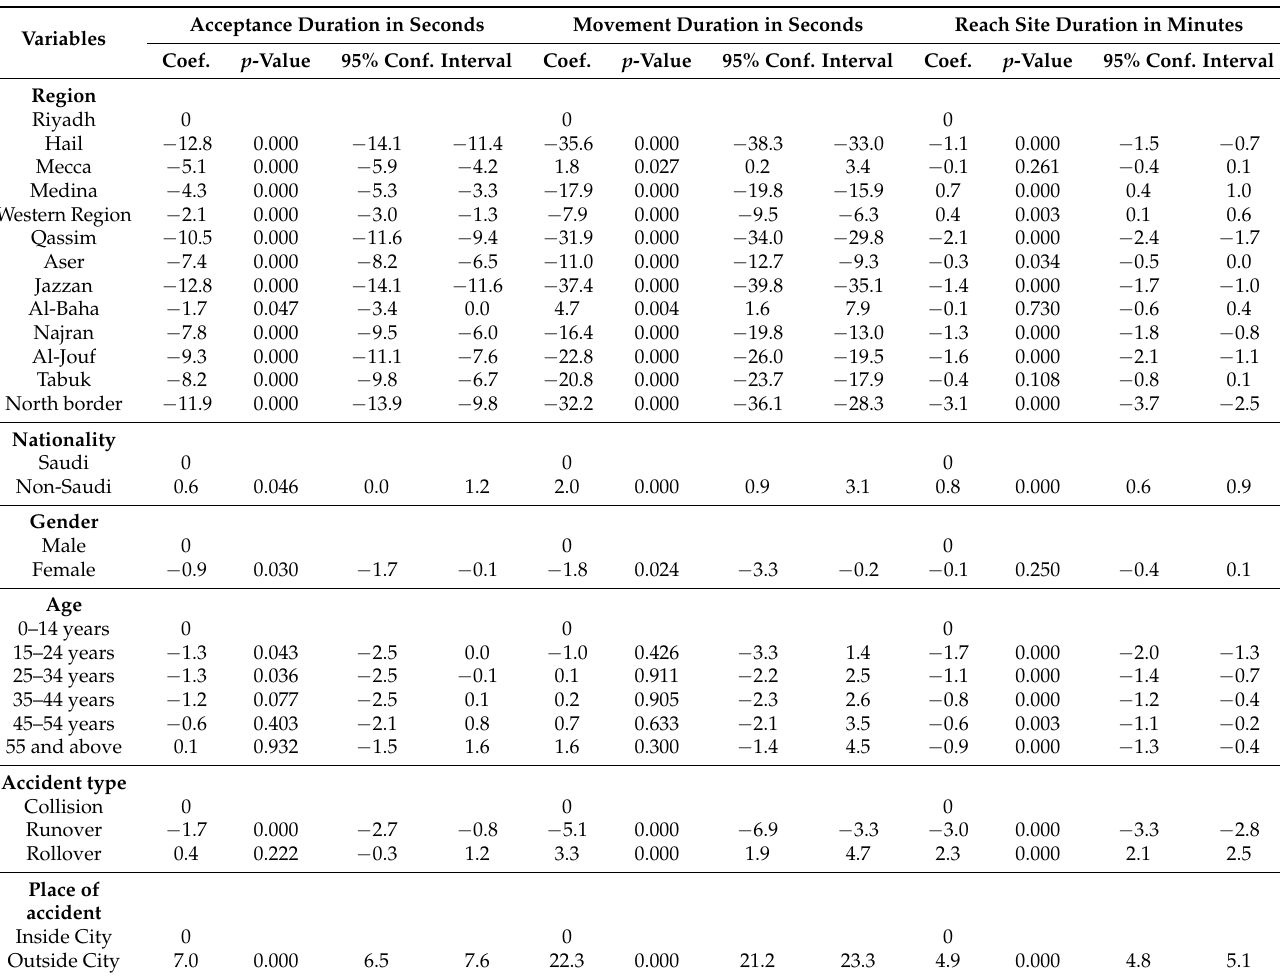
Table 3. Predictors of SRCA’s response time to road traffic accidents in the